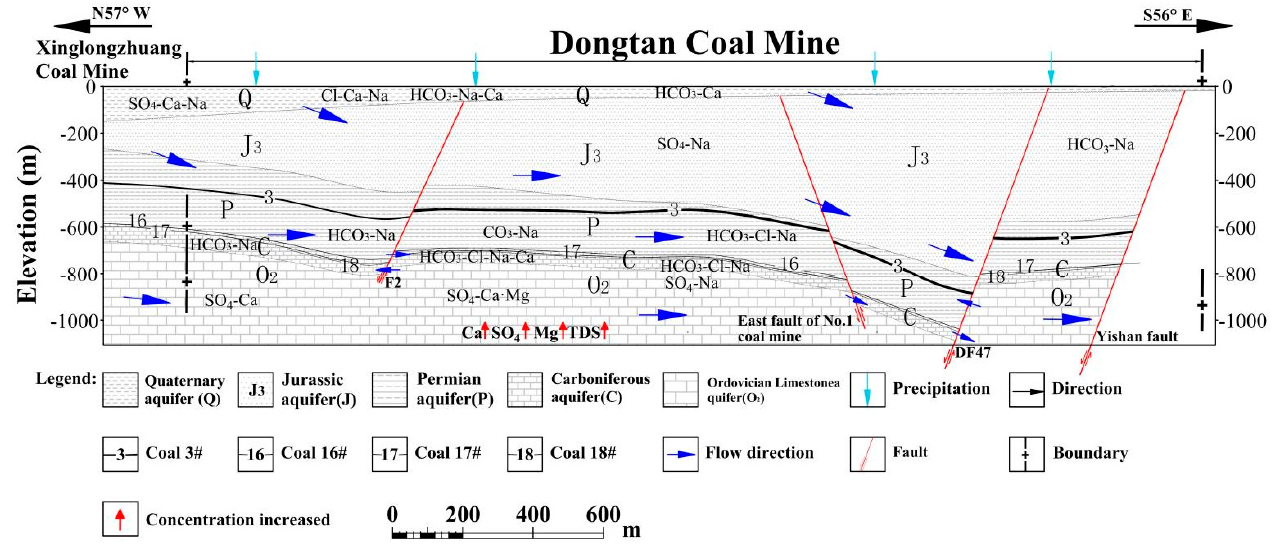
Figure 9. Hydrogeological conceptual model of the Dongtan Coal Mine.